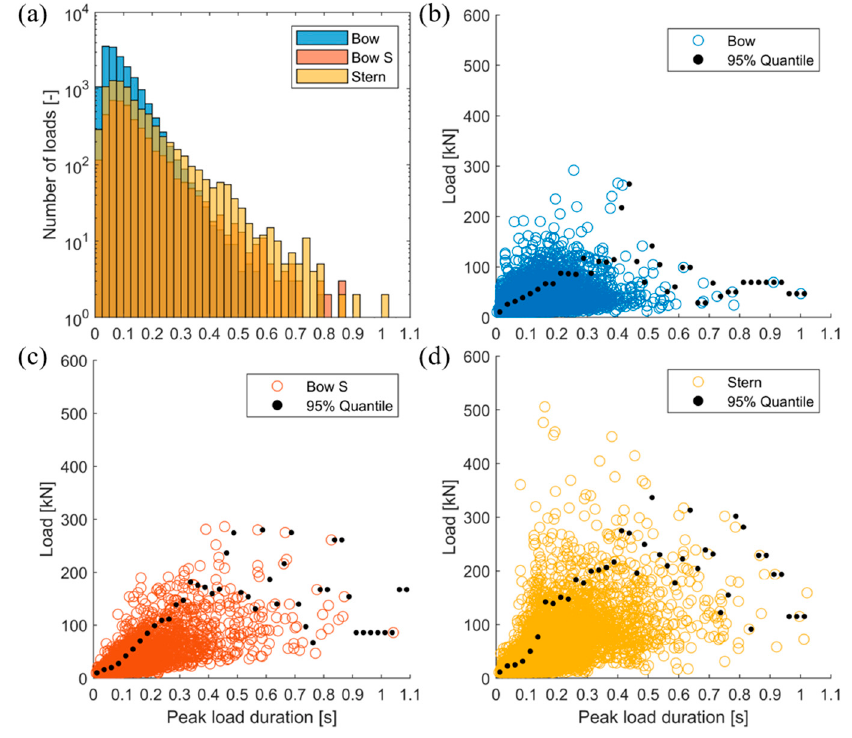
Figure 12. Duration of peak loads from all the tests at ( a ) all hull regions in histogram format, and individual loads with calculated 95% quantiles at ( b ) bow, ( c ) bow shoulder, and ( d ) stern shoulder.